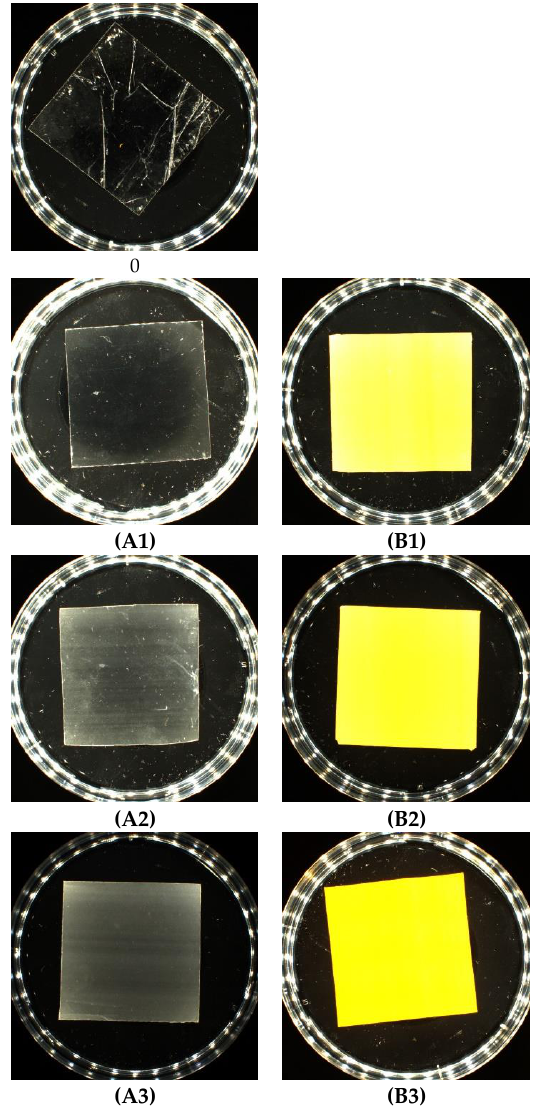
Figure 2. Photos of PLA samples modified with talc and riboflavin. Abbreviations: as in Table 2.